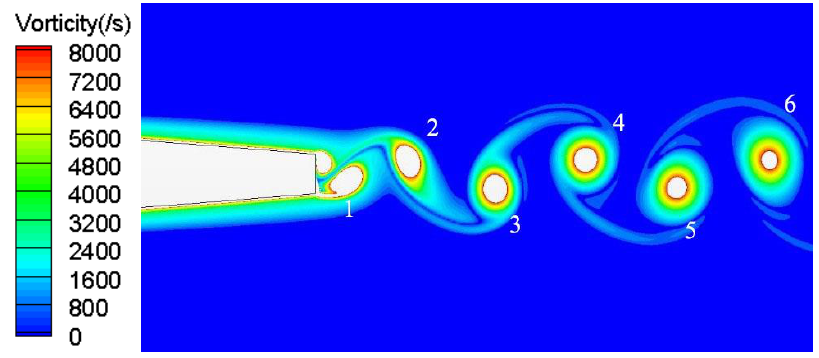
Figure 10. Vortex shedding from the trailing edge ( t = 3.12).